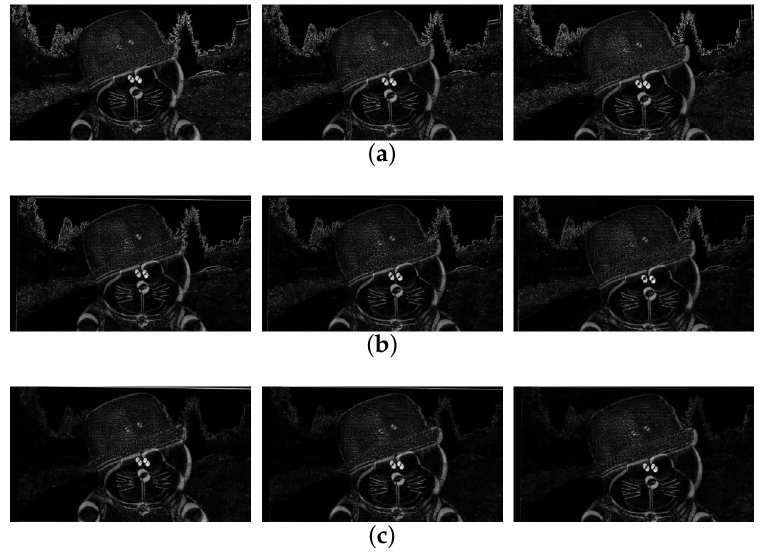
Figure 11. Experiment results: ( a ) differences of original video (66th, 67th, and 68th frames), ( b ) the stablized video of [10] (66th, 67th, 68th frames), ( c ) our stabilized video (66th, 67th, and 68th